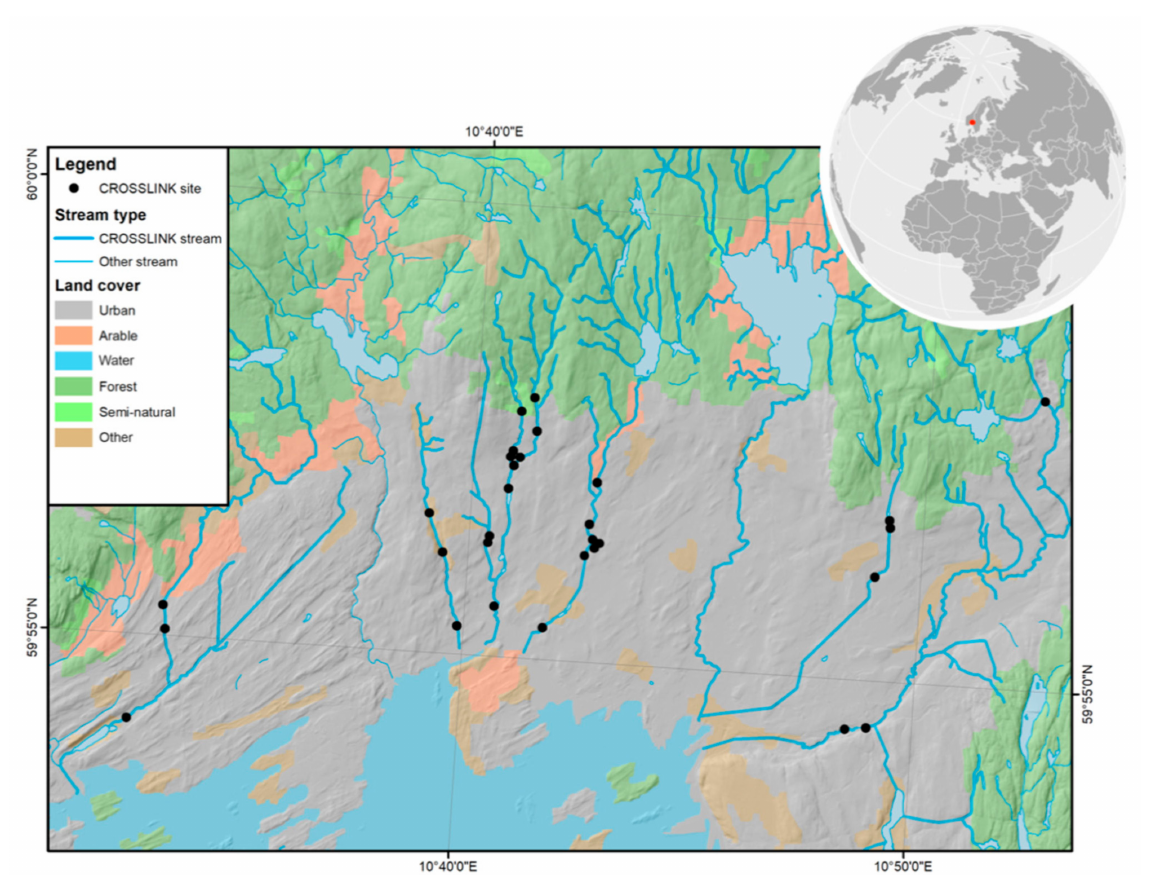
Figure 1. Location of study sites along the stream-riparian networks in the Oslo Fjord basin,